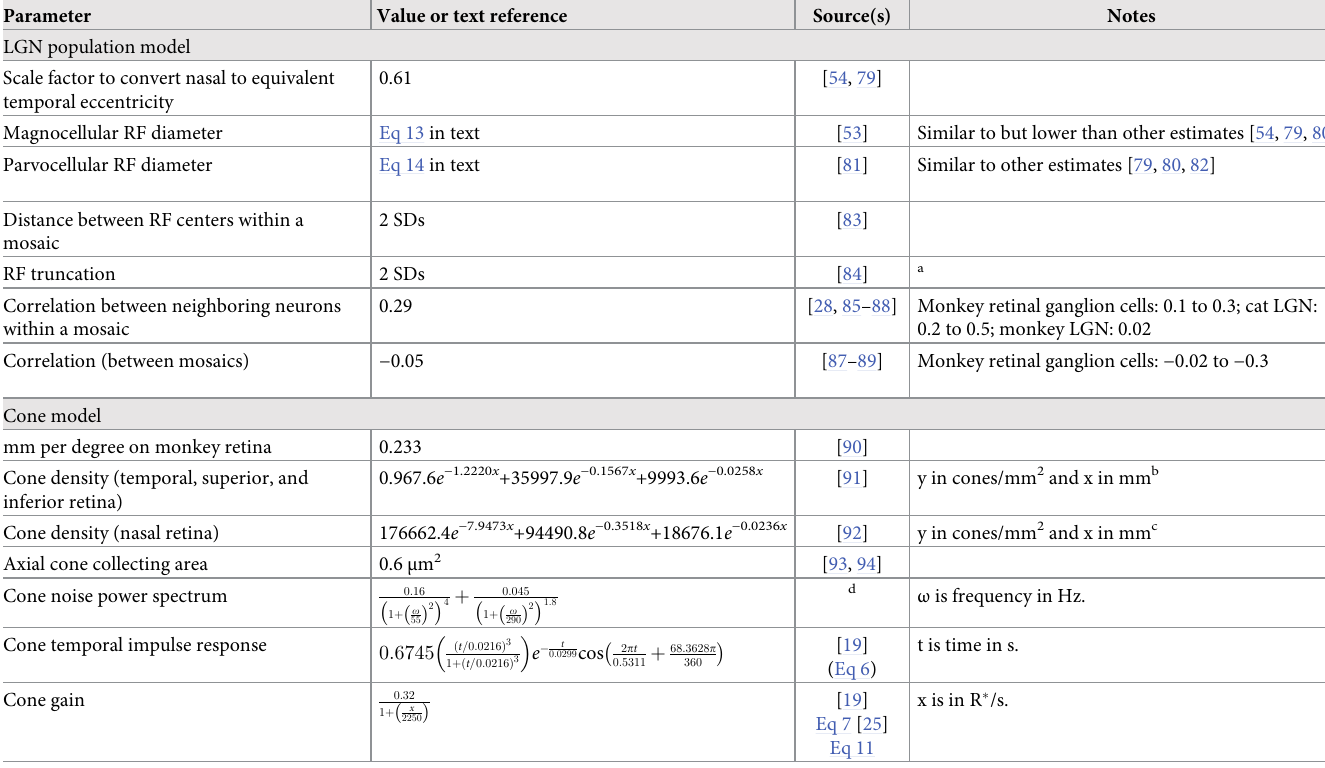
Table 1. Ideal observer model parameters and